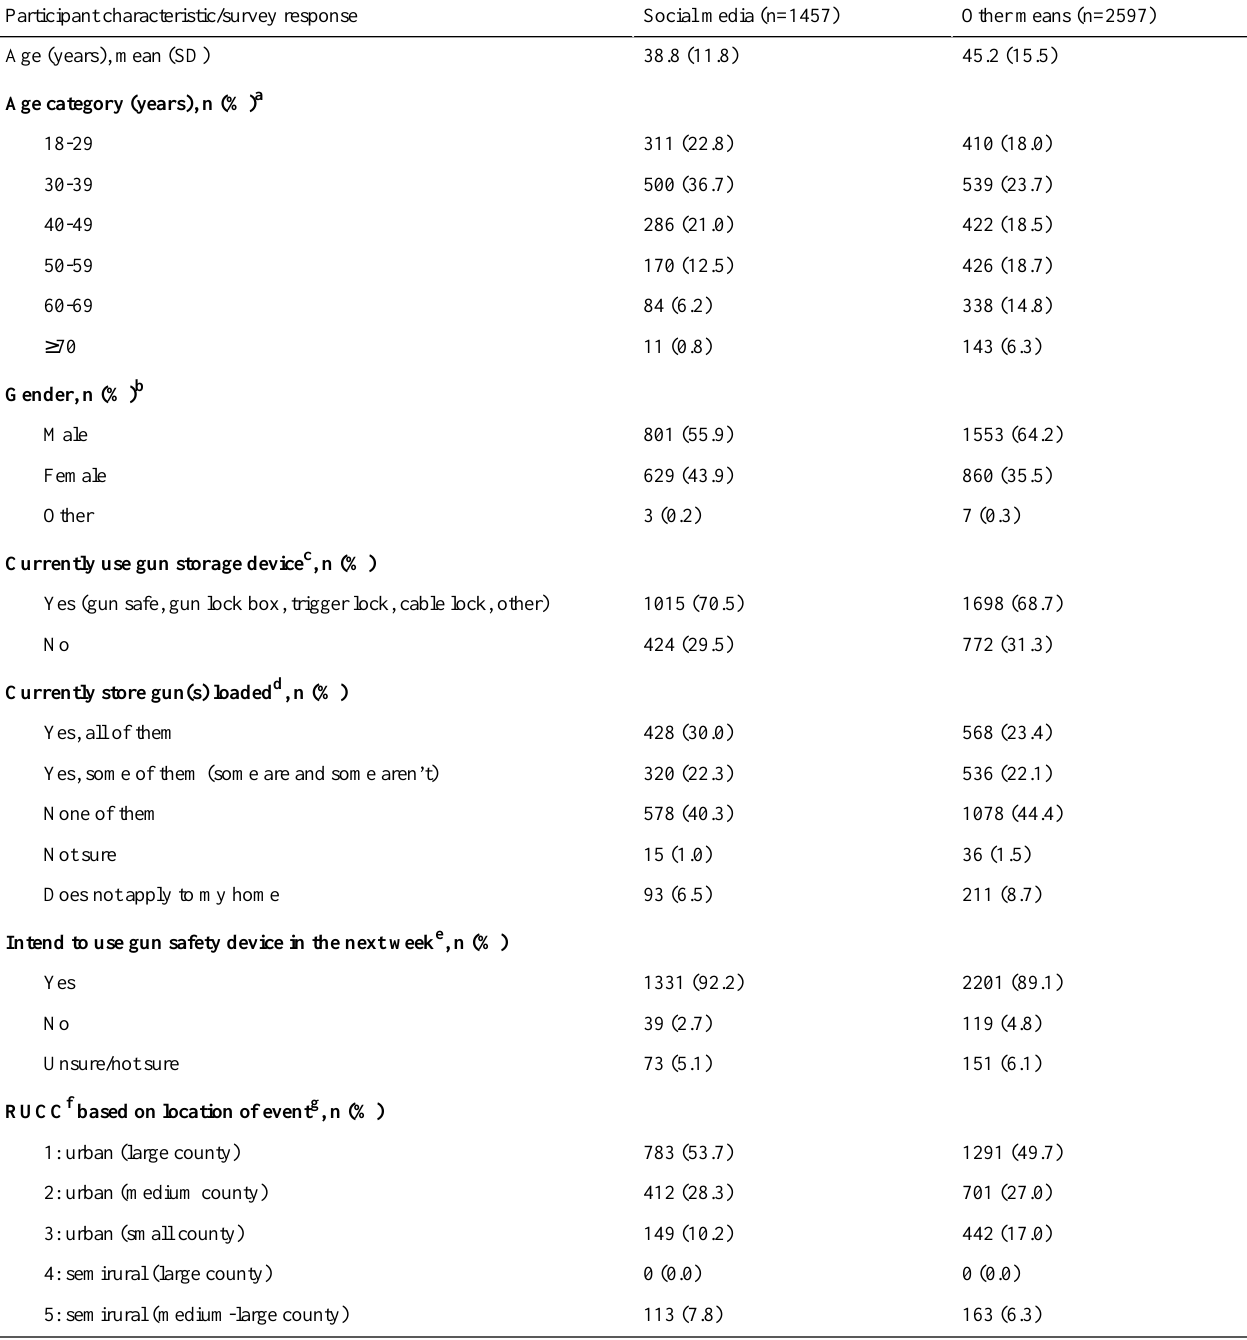
Table 3. Characteristics of participants who found out about Safe Firearm Storage Giveaway Outreach Events (2014-2018) through social media or other